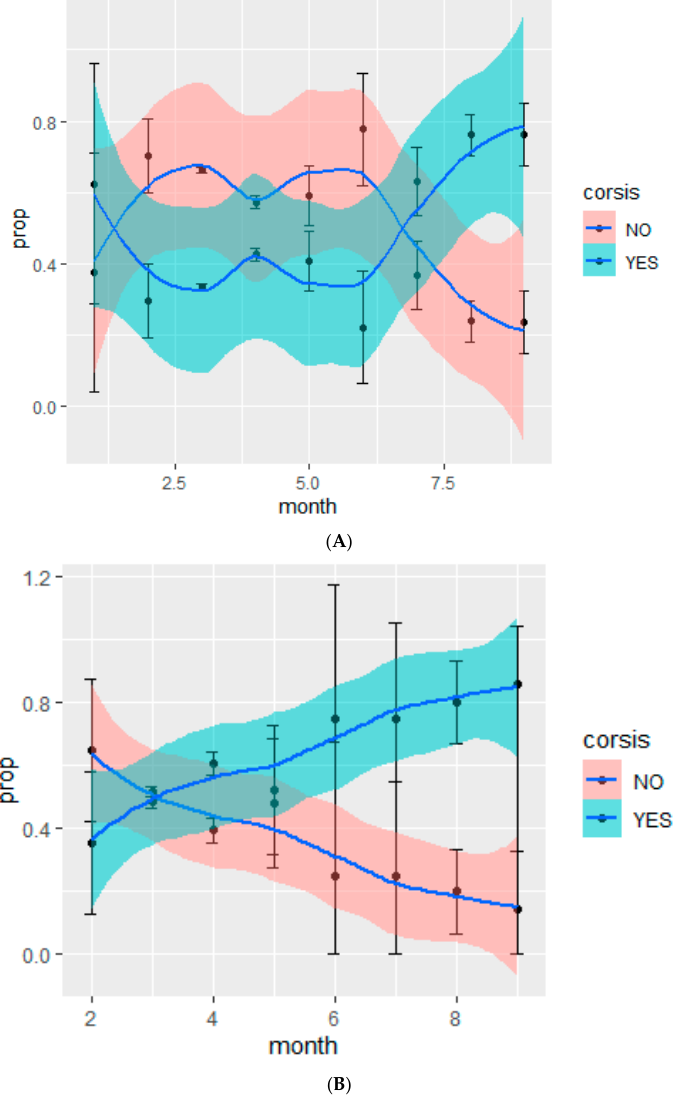
Figure 2. ( A ) Proportion of patients receiving and not receiving corticosteroids during the pandemic in hospitalised pa- tients with COVID-19; ( B ) proportion of patients receiving and not receiving corticosteroids during the pandemic in pa- tients with severe COVID-19 (modified WHO criteria). Prop: proportion, corsis: systemic corticosteroids. Accumulated prednisone equivalent dose (APED) used changed from March when 6.2, 5.7, 3.7 and 8.8% of patients received 200–400, 400–600, 600–800 or more than 800 mg, respectively, to September, when 31.4, 11.2, 13.4 and 6.7% received those doses ( p < 0.001,